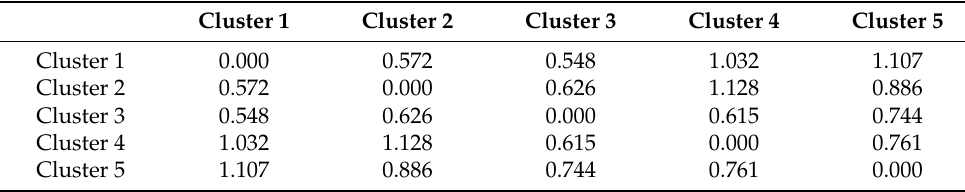
Table 4. Average cluster distances (based on the Euclidean distance).